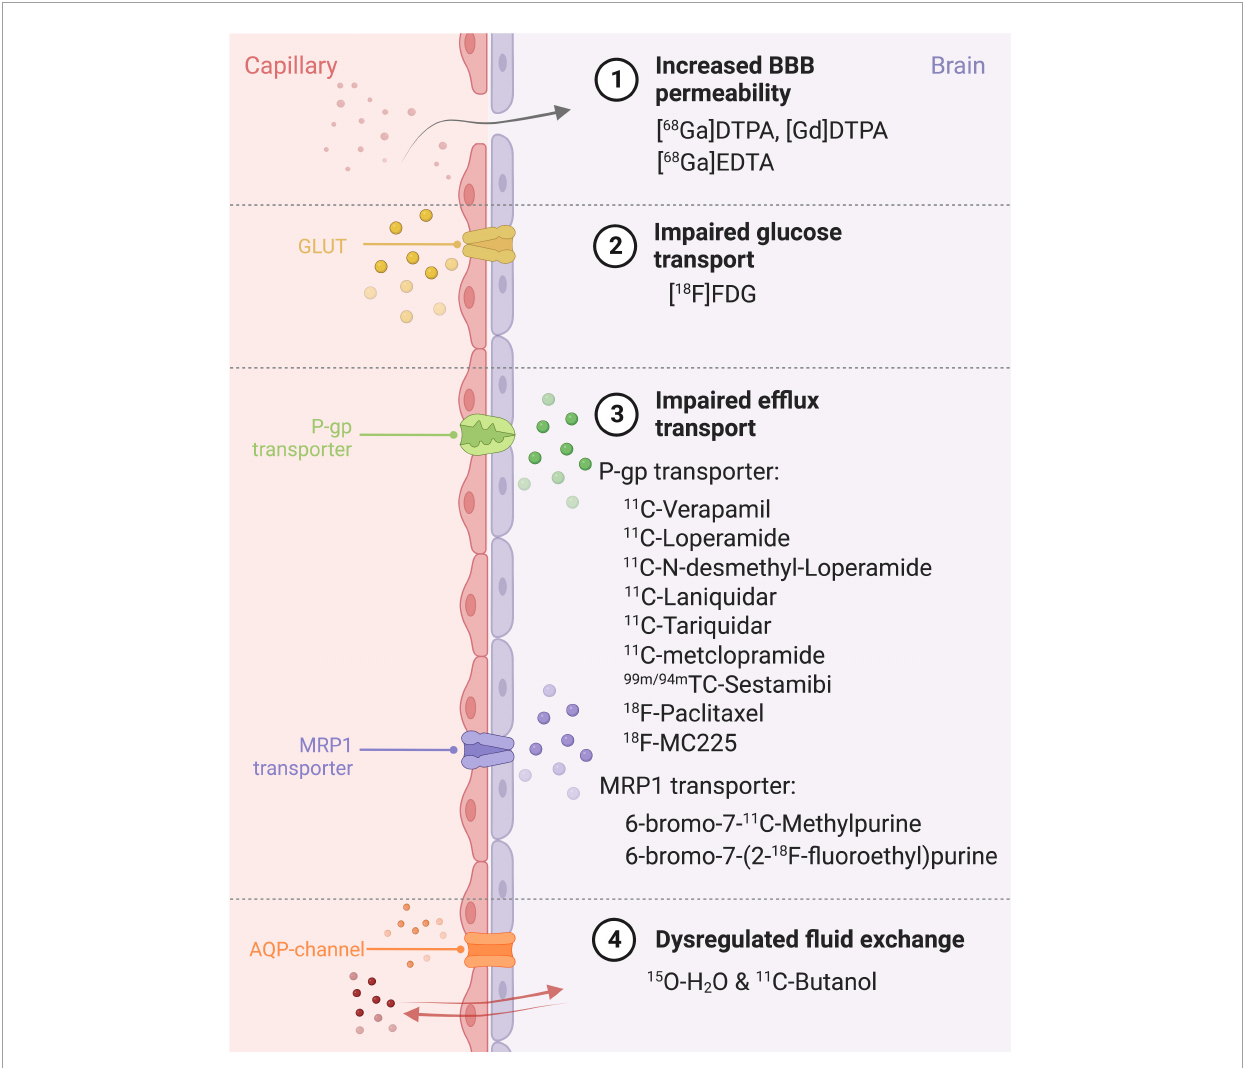
FIGURE4 Different ways of BBB impairment, PET radiopharmaceuticals and their specific target on the blood-brain barrier. BBB, Blood-brain barrier; MRP1, Multidrug Resistance Protein 1; P-gp, P-glycoprotein; GLUT, glucose transporter; AQP, aquaporin; DTPA, diethylenetriaminepentaacetic; FDG,